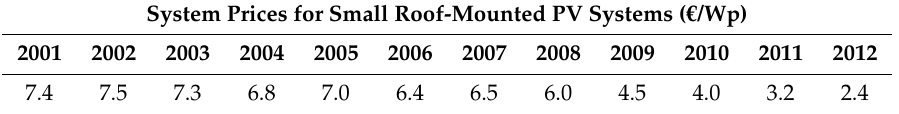
Table 7. System prices for small roof-mounted PV systems in